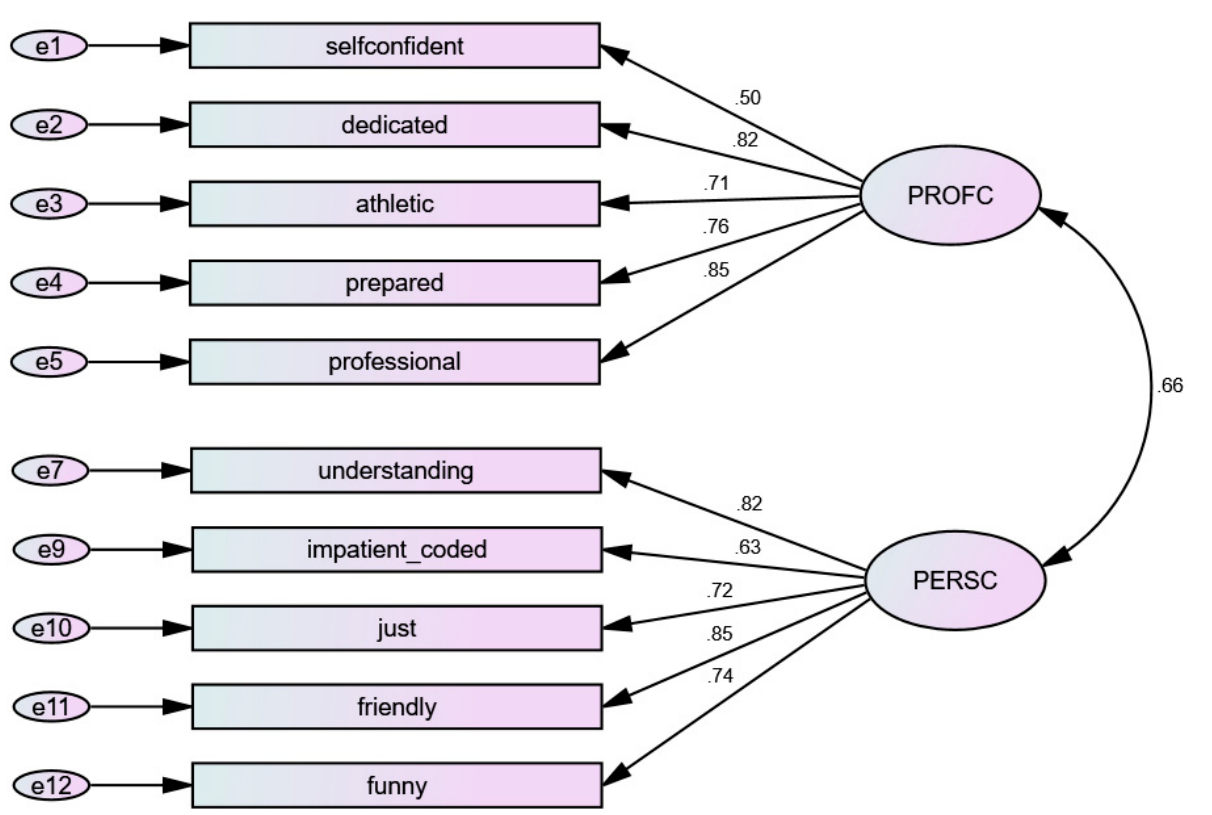
Figure 1. Final structural model for the pool of adjectives describing physical education teachers’ characteristics. Note. PROFC = Professional Characteristics; PERSC = Personal Characteristics.